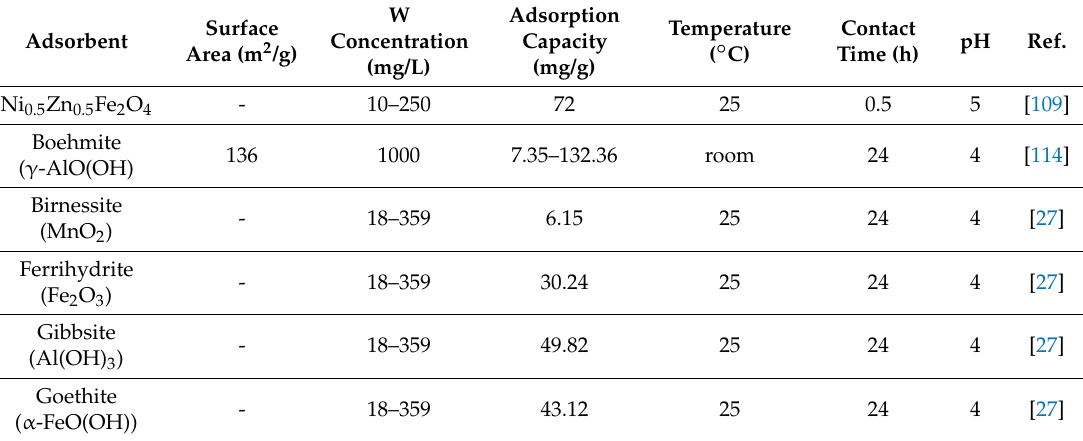
Table 5. Sorption properties of metal oxide-based adsorbents for tungsten oxyanions removal.